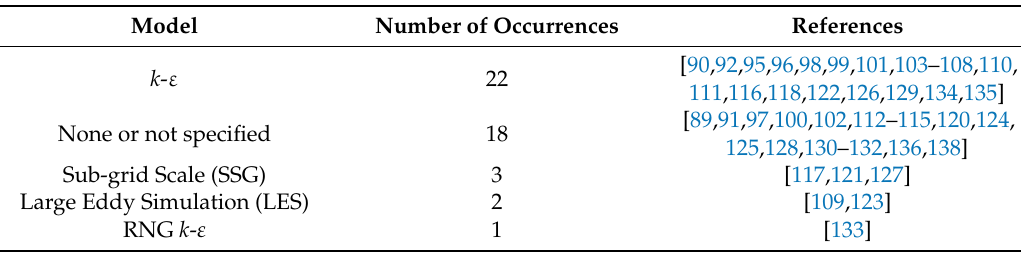
Table 4. Turbulence models used for DEM modelling in